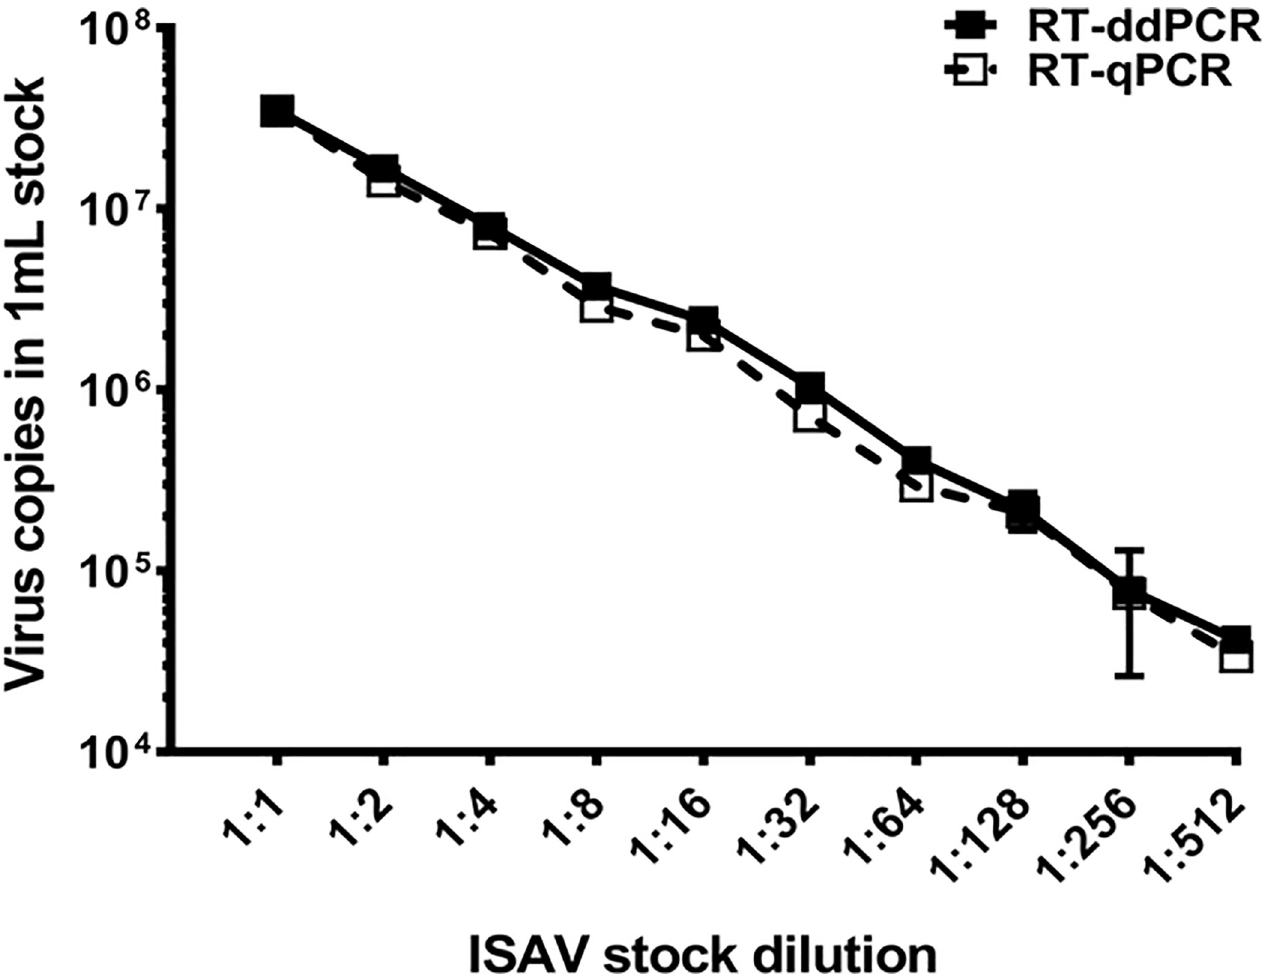
Fig 3. Quantification of ISAV (copy numbers/ml) in two-fold serial dilutions (1:1–1:2 9 ) of the stock sample, using RT-qPCR and RT-ddPCR. The plot represents the assay sensitivity of both PCR methods. Duplicate experiments for both RT-qPCR and RT-ddPCR were performed as technical replicates from the same RNA extracted from the dilution series of the ISAV